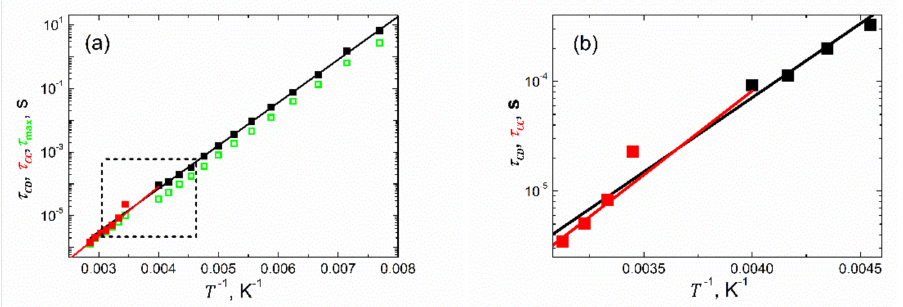
Figure 9. Arrhenius-type presentation of the relaxation times shown in Figure 8d. ( b ) Data replotted from the area marked with a rectangle in ( a ) to visualize the intersection of the fitting